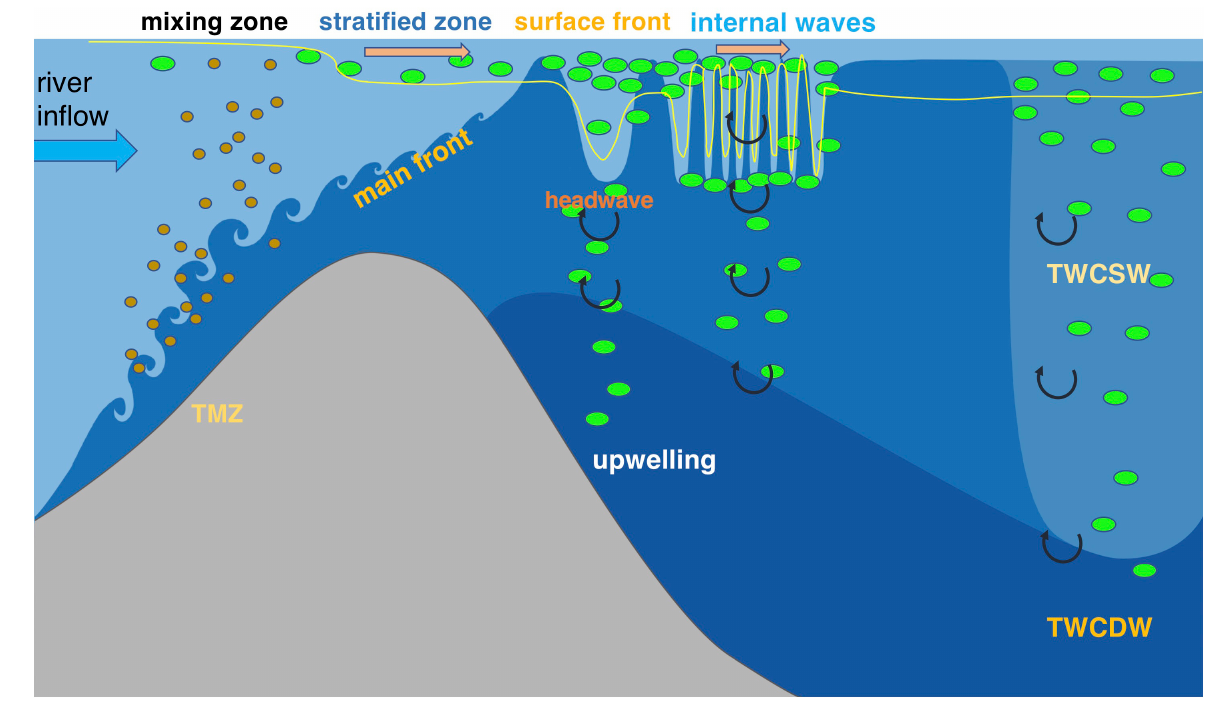
Frontiers in Marine Science |